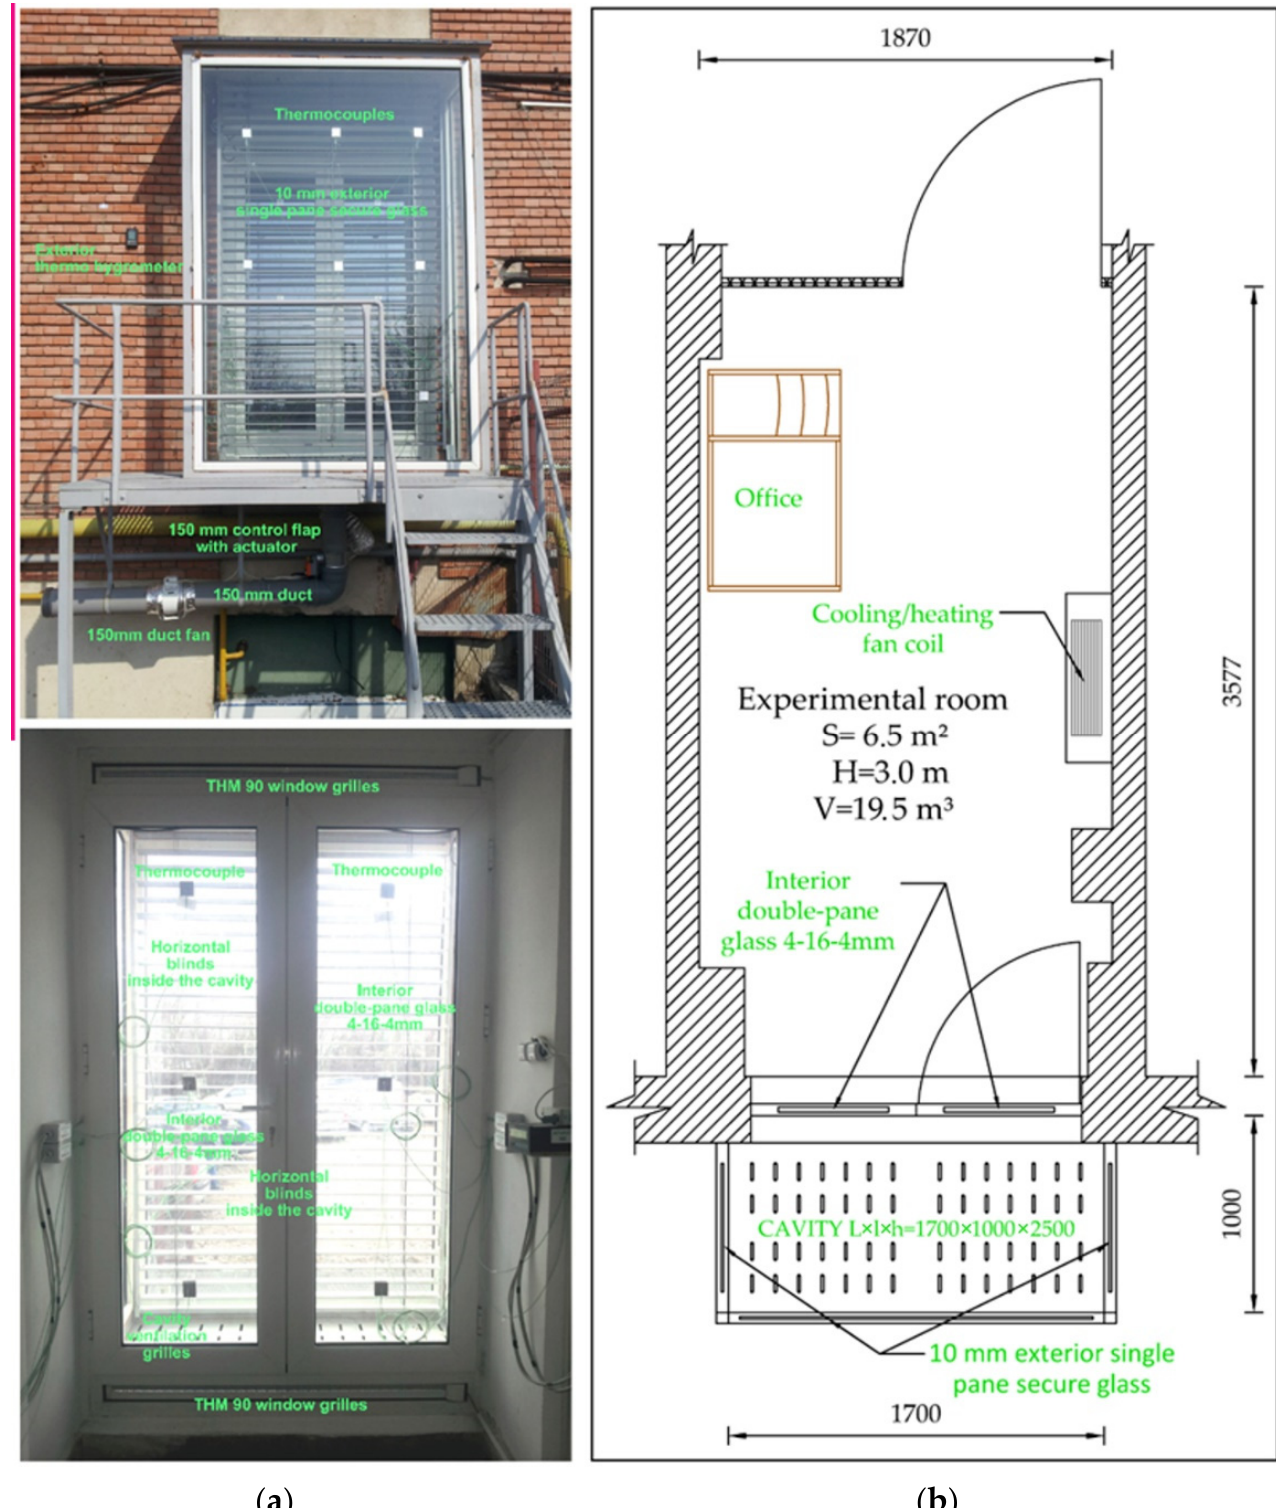
Figure 2. Exterior view of the experimental model ( a - top ) and interior views of the experimental chamber ( a - bottom ). Overall dimensions and configuration of the experimental chamber ( b ).